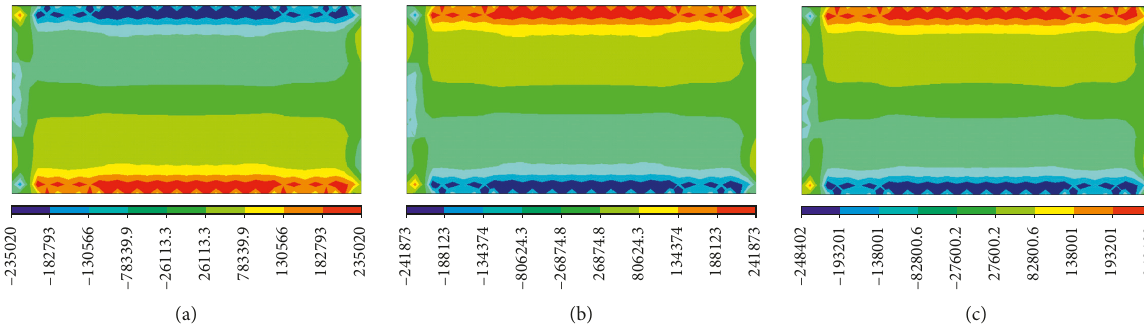
Figure 25: Tangential stress of interface under condition 2. (a) P